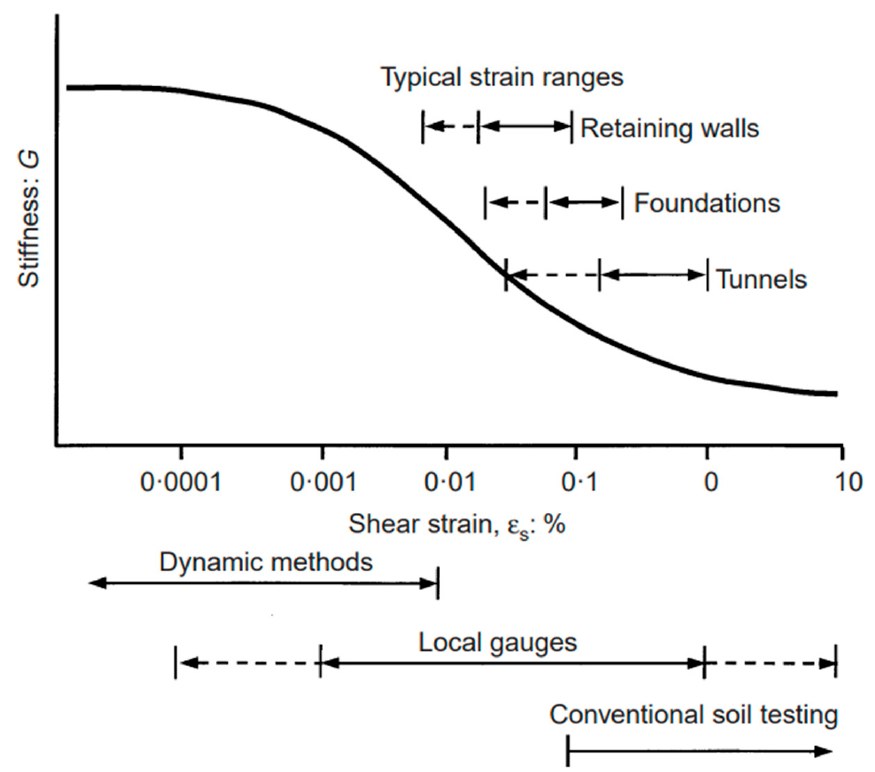
Figure 2. Characteristic stiffness-strain behaviour of soil with typical strain ranges for laboratory tests and structures (after [25,26]). (Reprinted with permission from Atkinson © 2000 ICE Publish- ing).